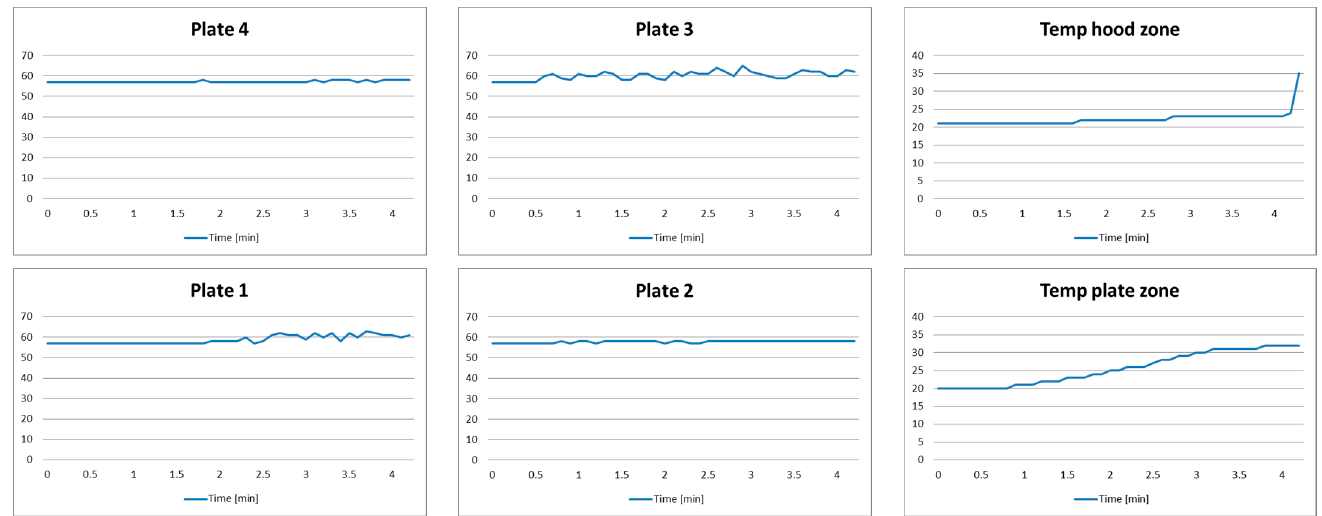
Figure 6. Test results of Scenario 2.